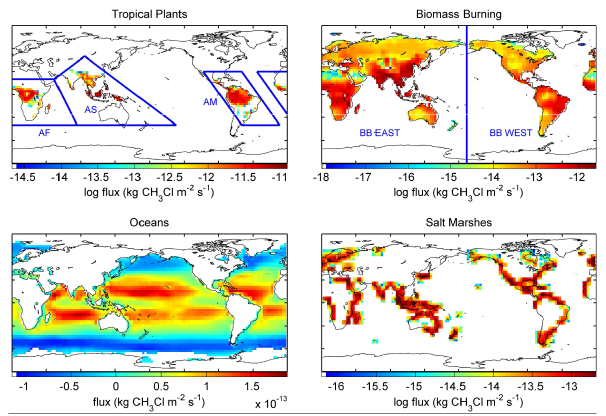
Fig. 4. Annual average distributions of additional CH 3 Cl monthly varying emissions and the soil sink. Note that the small industrial, incineration and wetland sources are assumed to be equal to their reference values and are not estimated. Seasonal variability of the small fungal emissions is not considered in the